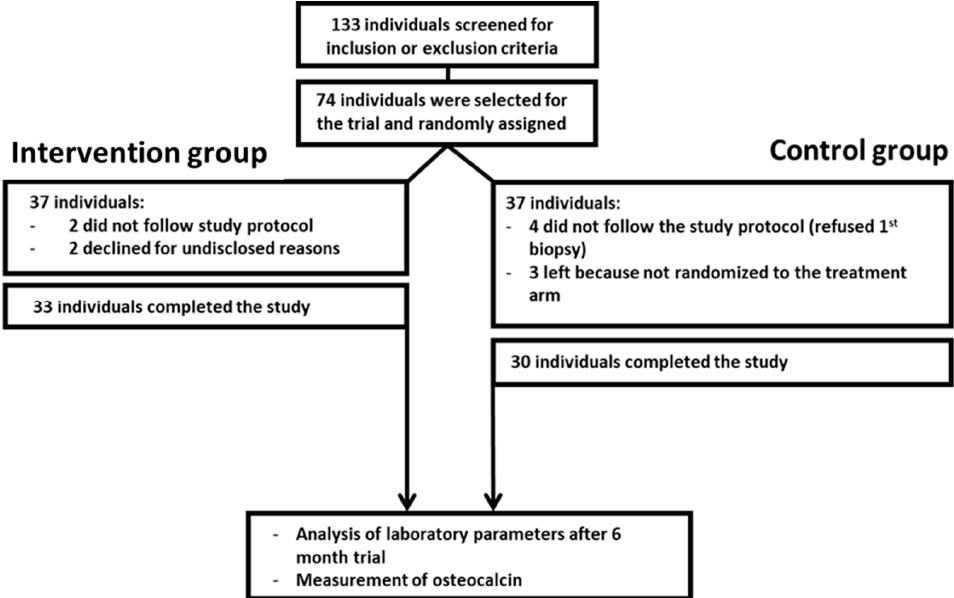
Figure 1. Schematic of study design. The study was embedded within a two-armed, controlled, monocentric, randomized, 6-month intervention period. Paired blood samples were collected before and after the 6-month intervention period. Thirty participants in the control group and 33 in the intervention group completed the study and were included in the data analysis. Two participants of the intervention group and four of the control group did not follow the study protocol, and three participants of the control group left the study due to not being included in the weight loss program (intervention group). The remaining two dropouts of the intervention group declined to continue for undisclosed reasons.